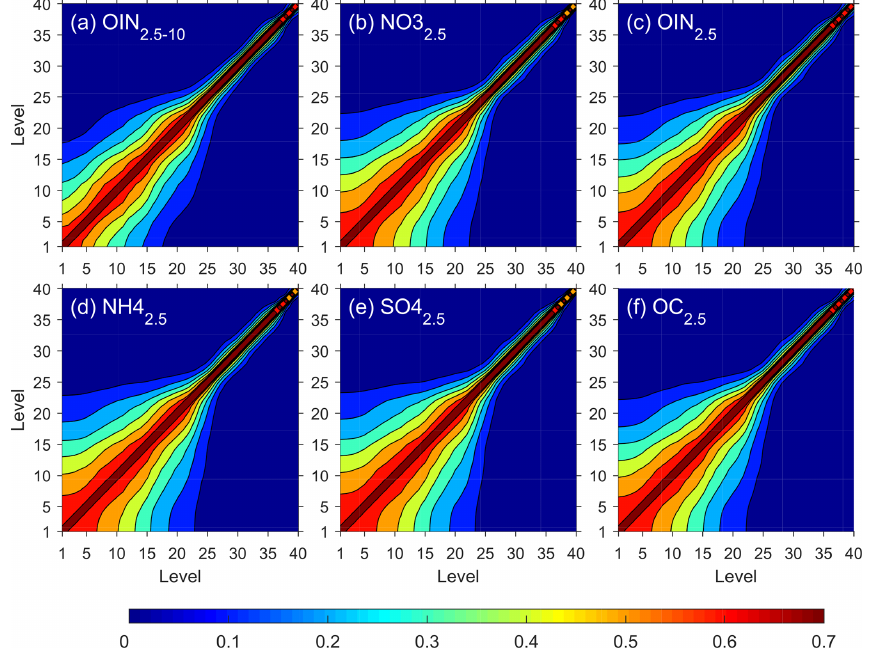
Figure 3. BEVCCs of six control